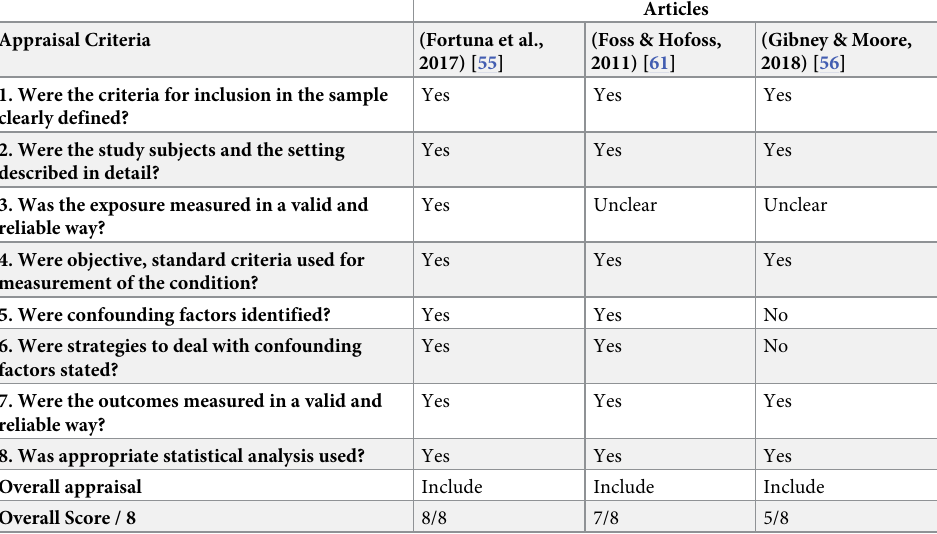
Table 2. Assessment of the quantitative studies: JBI critical appraisal checklist for analytical cross-sectional